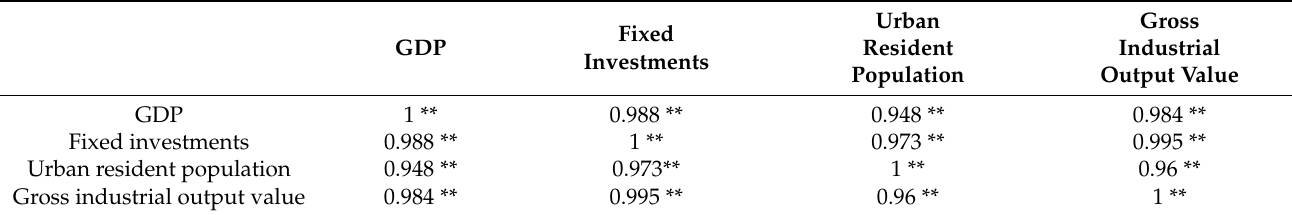
Table 6. Correlation matrix of urbanization factors.